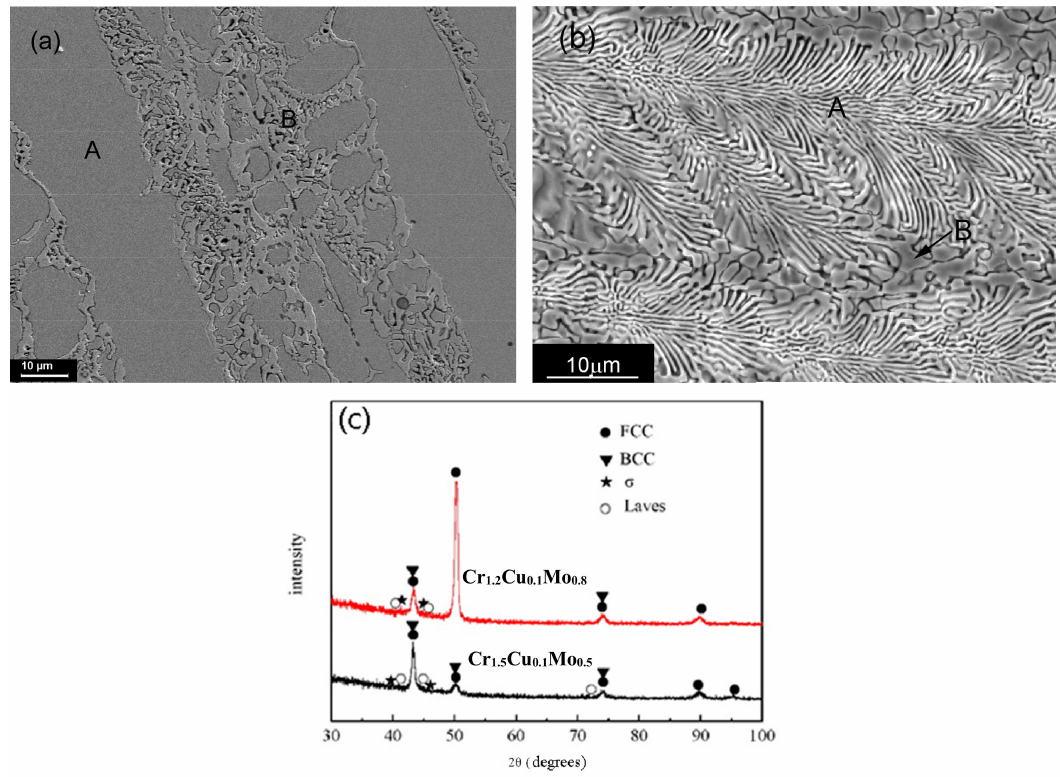
Figure 2. The SEM micrographs and phase structures of CoCr b Cu 0.1 FeMo 2 − b Ni alloys. ( a ) CoCr 1.2 Cu 0.1 FeMo 0.8 Ni; ( b ) CoCr 1.5 Cu 0.1 FeMo 0.5 Ni; ( c ) XRD